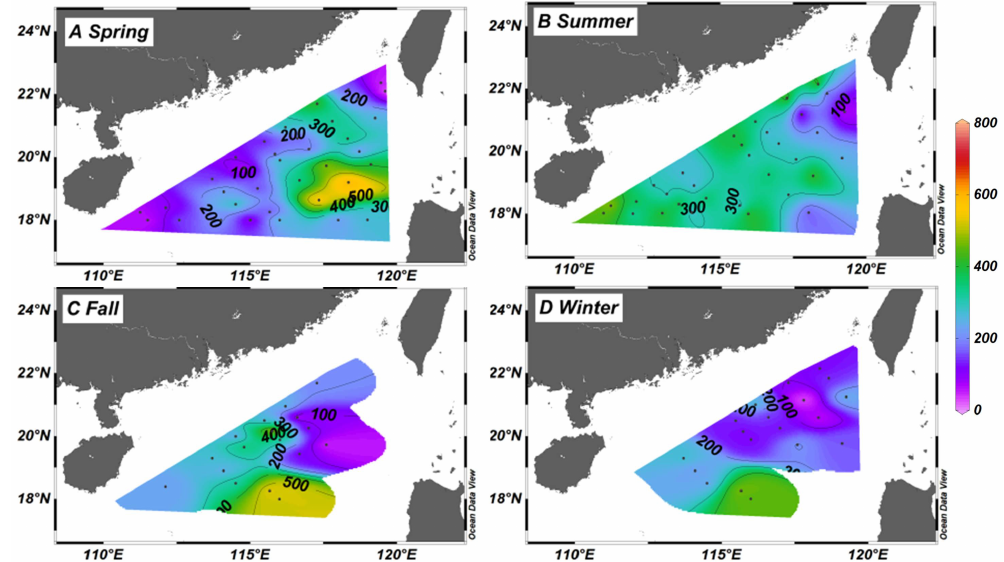
Fig. 5. Station-integrated N + N inventory (mmolm − 2 ) in the upper 100m of the water column in the central northern South China Sea. (A) spring; (B) summer; (C) fall; and (D) winter.